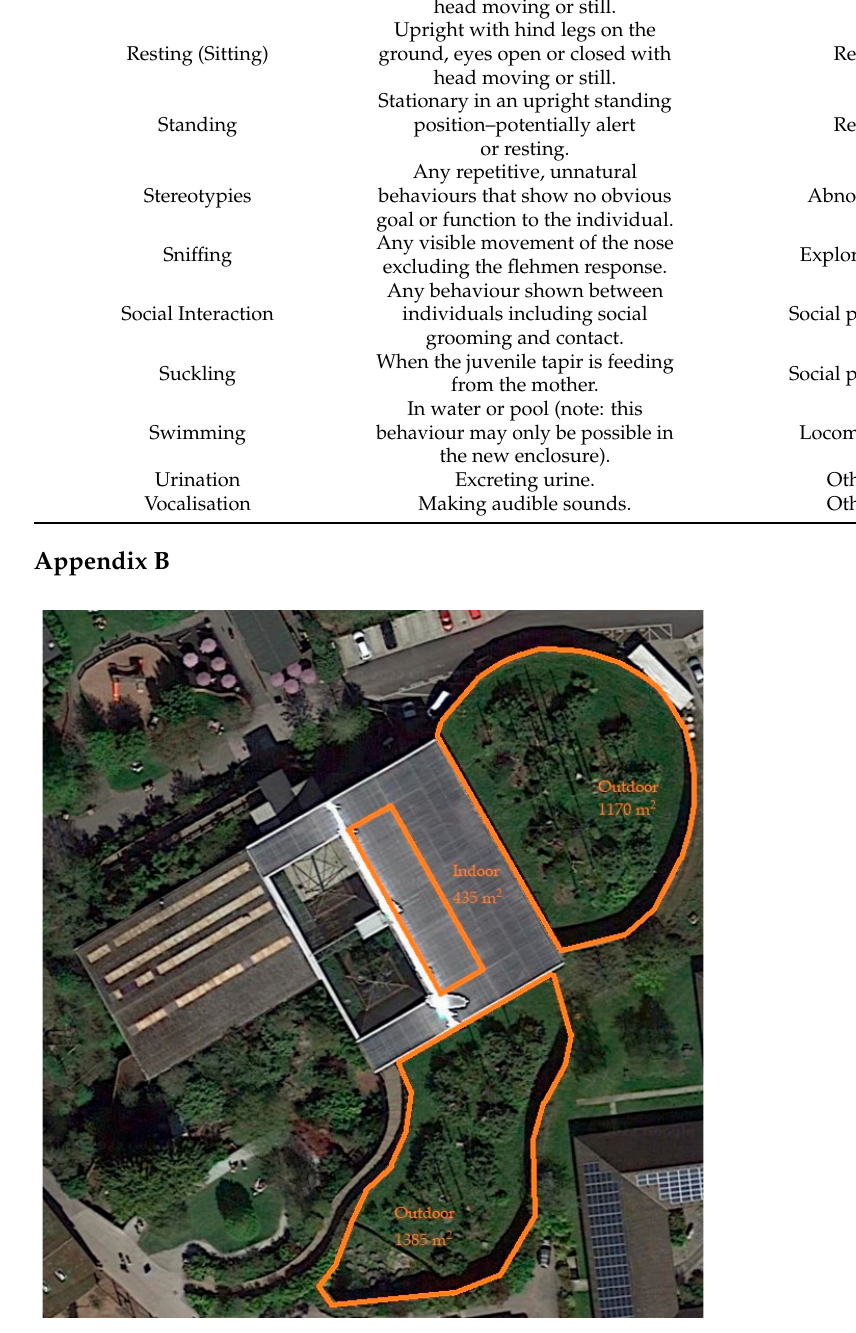
Figure A1. Enclosure plan for Sumatran orangutans ( Pongo abelii ) in the Realm of the Red Ape exhibit in which individuals were housed during the pre-move data collection period. Orange lines signify approximate areas accessed by individual animals with dimensions of total available space. Copyright: Google Earth.